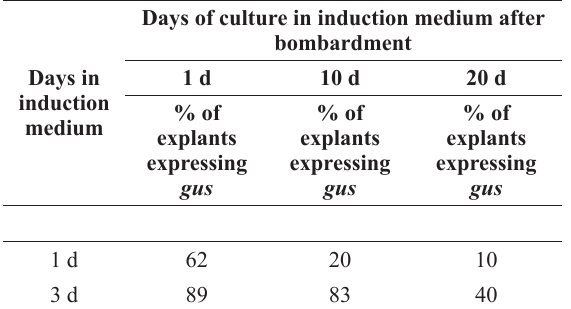
Expression of gus in isolated embryos of Brachiaria brizantha cv. Marandu after bombardment, according to different periods of time in induction medium prior to bombardment.